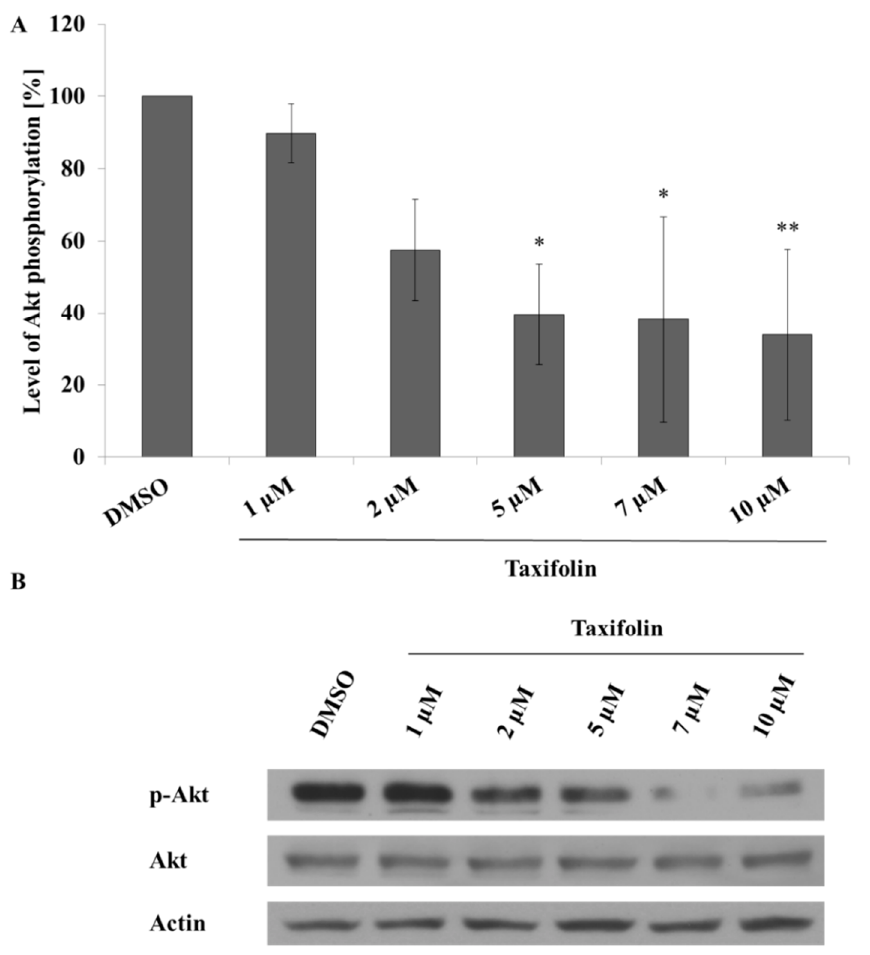
Figure 4. Modulation of Akt phosphorylation (Ser473) by taxifolin. Panel ( A ): Hep G2 cells were seeded and incubated with different concentrations of taxifolin or negative control (contains only DMSO). Akt phosphorylation was evaluated by Western blot after 24 h of incubation. Each bar represents mean ± SD of three independent experiments. Panel ( B ): representative Western blot. * p < 0.05 (** p < 0.01) versus negative control.